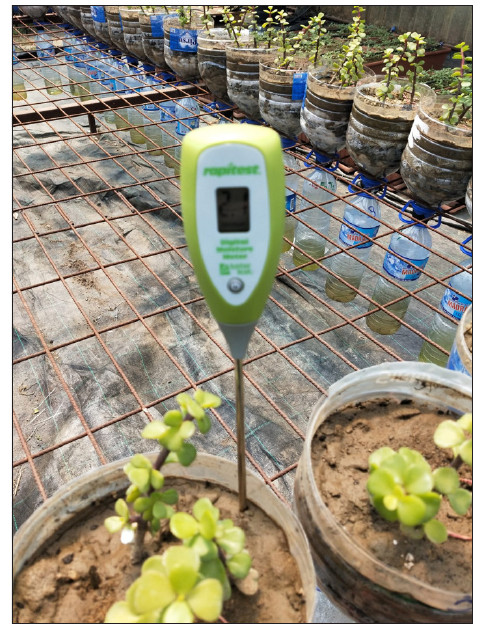
Figure 3. Digital soil thermometer